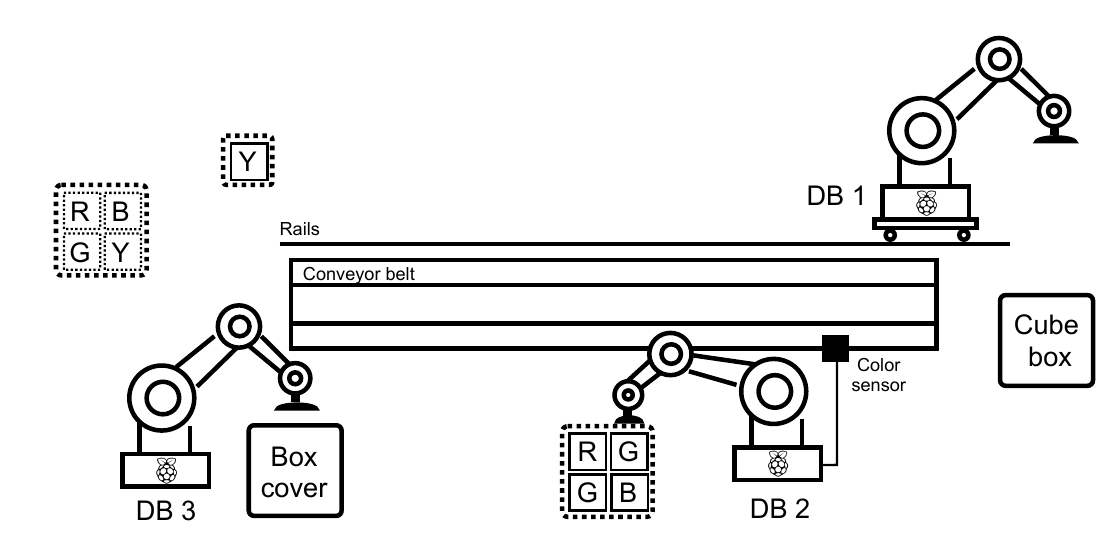
Figure 16. Scheme of production